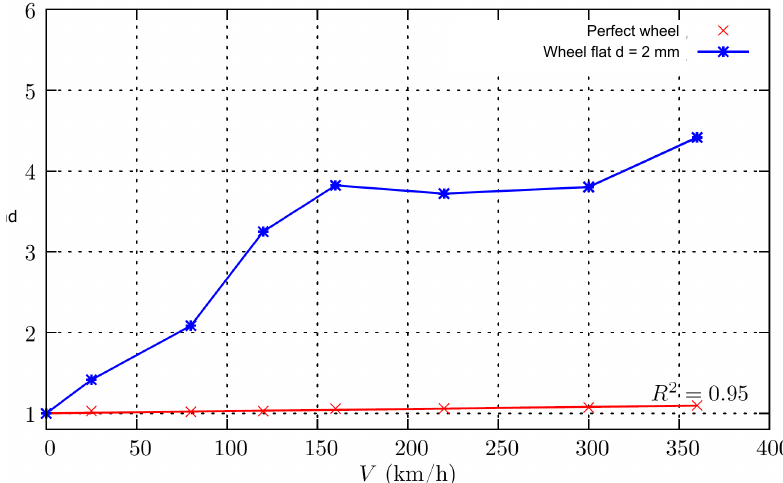
Figure 7. Dynamic amplification factor for the dynamic load: perfect wheel vs. flat wheel ( d = 2 mm), ballasted track.